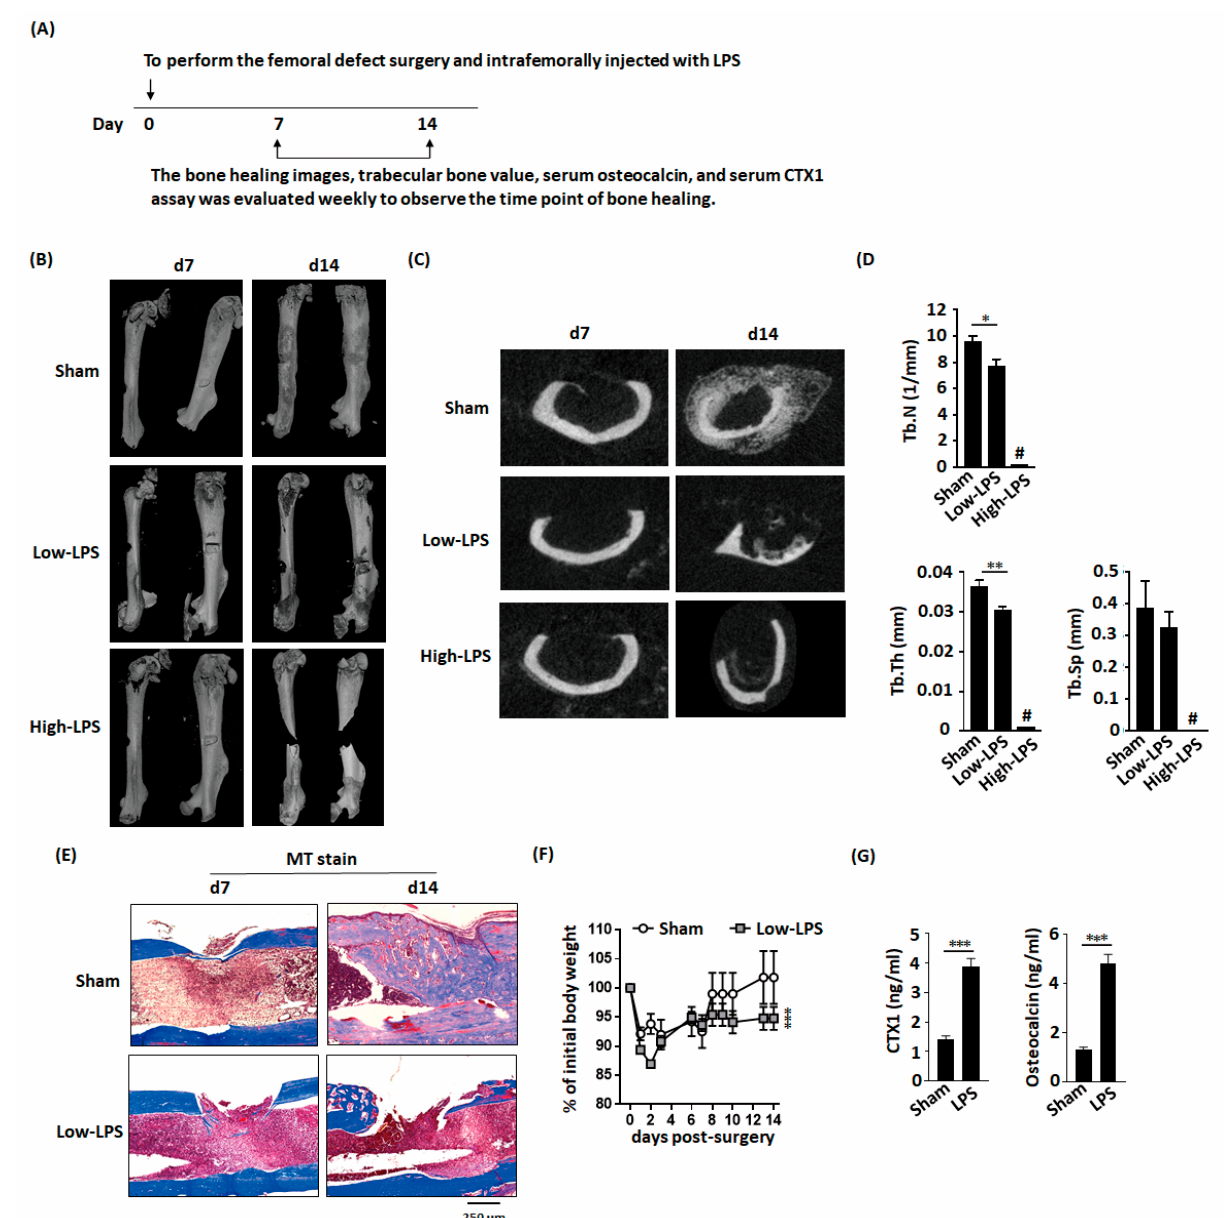
Figure 1. Lipopolysaccharides (LPS) delayed new bone formation and bone healing in mice with femoral bone defects. ( A ) Schematic representation of the experimental setup. ( B ) Micro-computed tomography (microCT) three-dimensional image of the bone defect site show that low-dose LPS delays bone healing and high-dose LPS promotes bone fracture in the bone defect area. ( C ) Representative transverse images of the fractured femur by microCT. ( D ) LPS decreases the trabecular number and thickness. ( E ) MT stained histological sections demonstrate LPS inhibits bone bridge formation during bone healing. ( F ) LPS impairs body weight recovery. ( G ) LPS increases the serum levels of CTX1 and osteocalcin, an indicator of the bone turnover rate. Data are presented as the mean ± standard error of the mean. Analyses were conducted with two-way analysis of variance followed by Bonferroni’s post-hoc test. * p < 0.05, ** p < 0.01, *** p < 0.001. Abbreviations: LPS, lipopolysaccharide; Tb.N, trabecular number; Tb.Th, trabecular thickness; Tb.Sp, trabecular separation; MT, Masson’s trichrome stain; CTX1, C-terminal telopeptides of type I collagen; #, full fracture. Sham, n = 5; Low-LPS, n = 7; and High-LPS, n = 5.